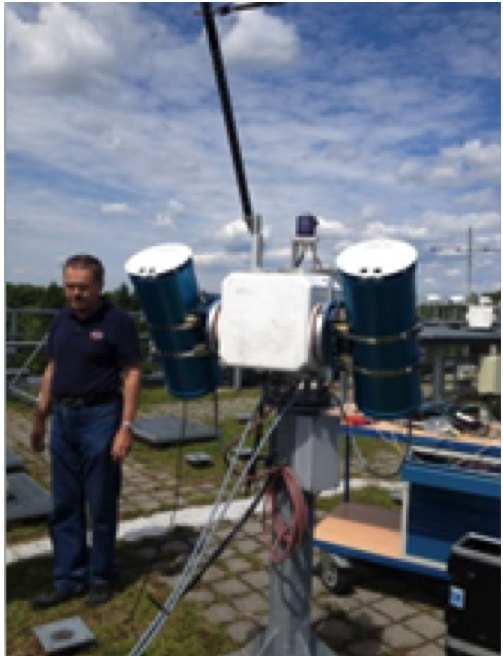
Figure 1. PSR#004 and PSR#006 installed on a sun-tracking device at